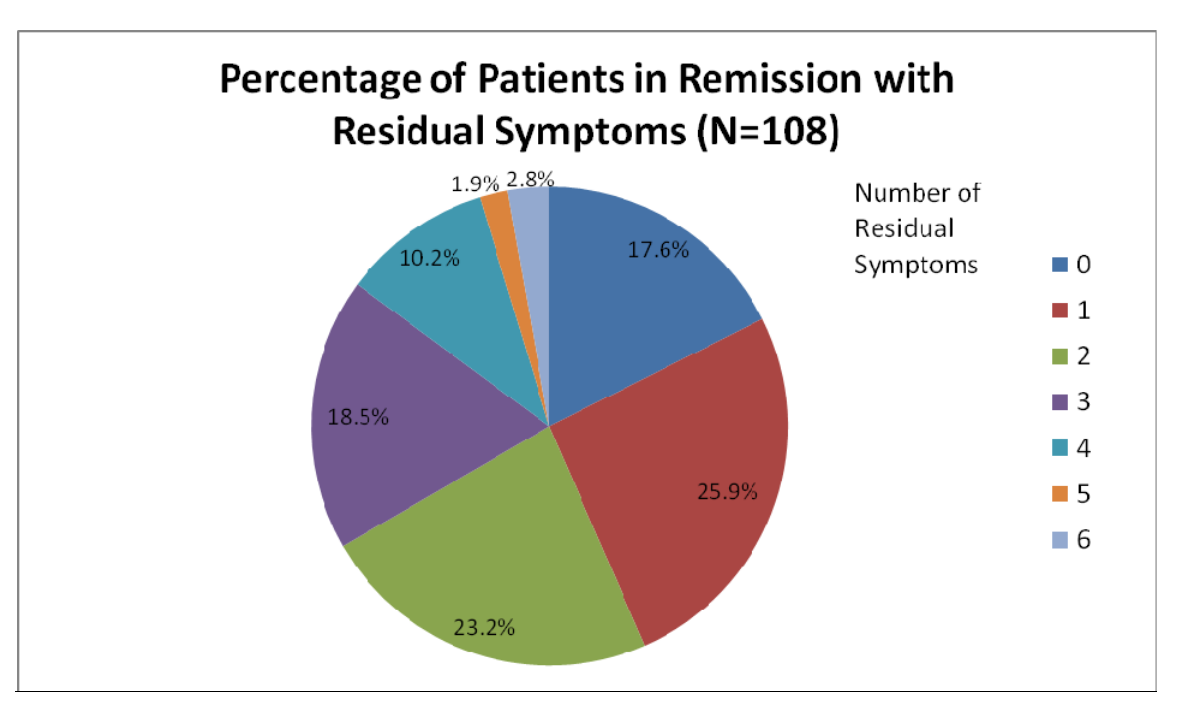
Figure 1. Patients in considered to be in remission from major depression who still had ongoing residual